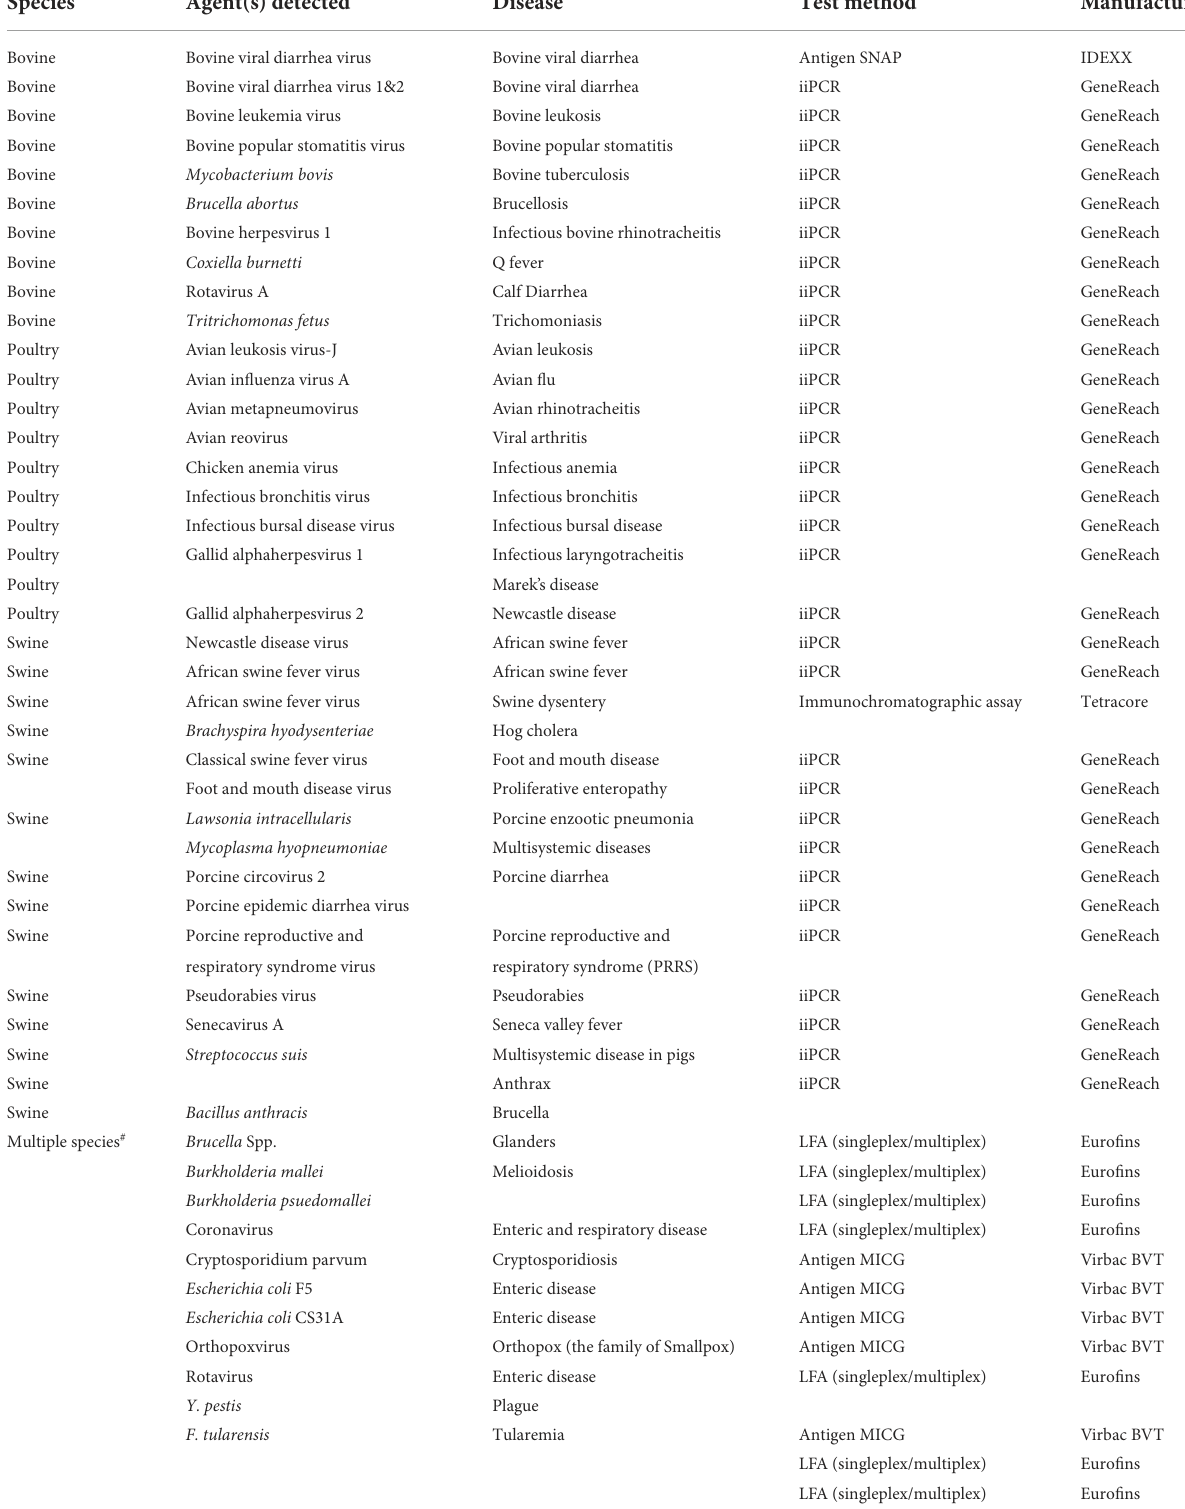
TABLE 2 Commercially available POCT diagnostics for infectious diseases of food animals ⋄ .